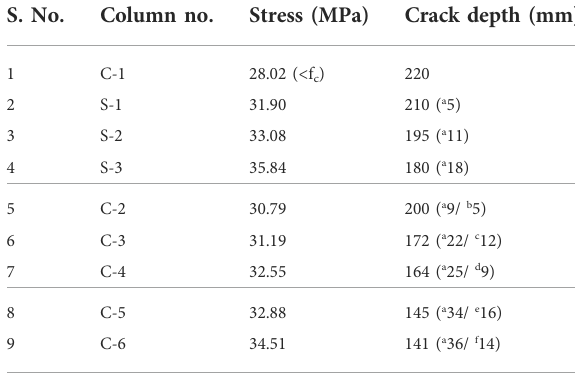
TABLE 4 Summary of maximum principal compressive stress in the concrete and average crack depth of fl exure – shear cracks. S. No. Column